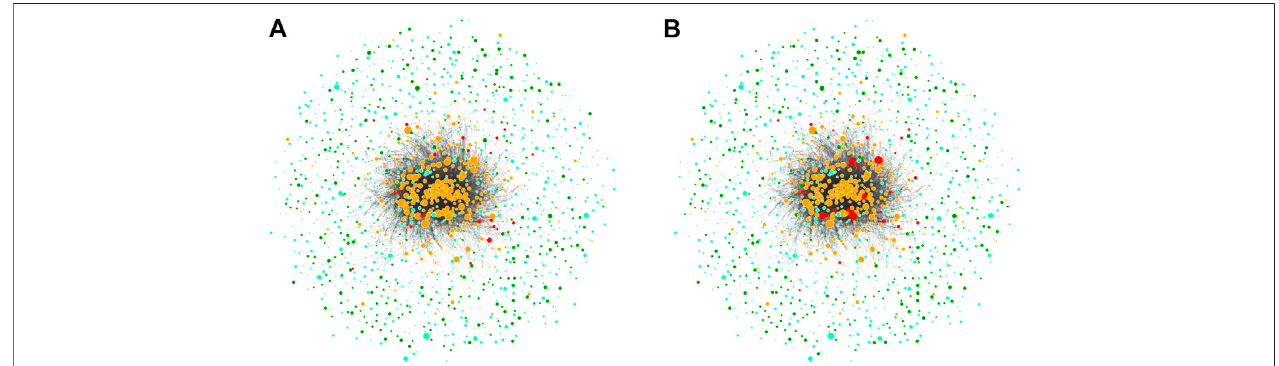
FIGURE 2 | Visualizations of two MDSs in the ownership network. The node size is scaled proportional to the operating revenue of the fi rm. Transnational companies (TNCs) are shown in orange and in red, if they are also driver nodes. Participated companies (PCs) are shown in light green and in dark green, if they are also driver